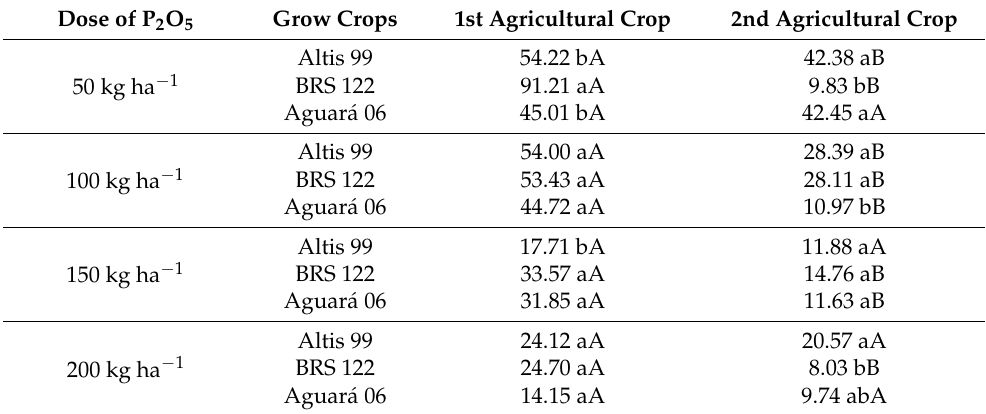
Table 4. Average values for apparent recovery efficiency as a function of sunflower cultivars within phosphorus doses in agricultural crops.